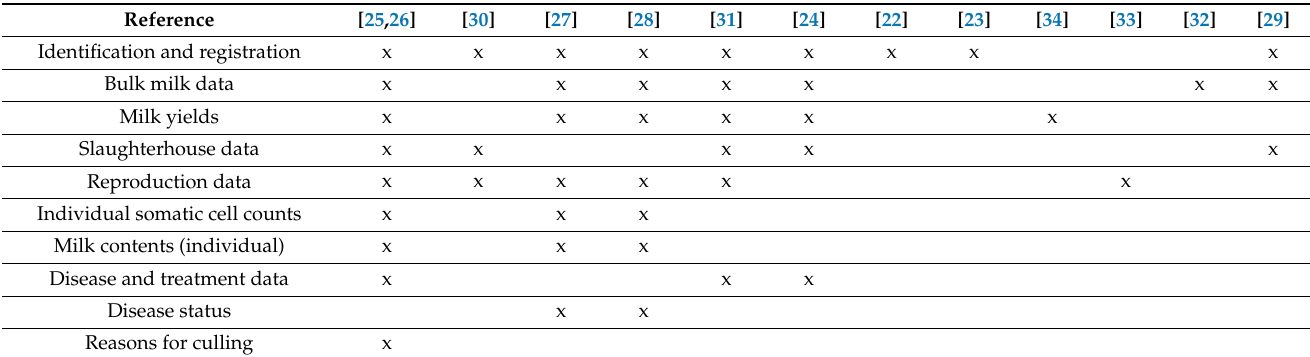
Table 3. Data sources used for the calculation of data-based variables used as potential predictors of dairy herd welfare in 13 identified